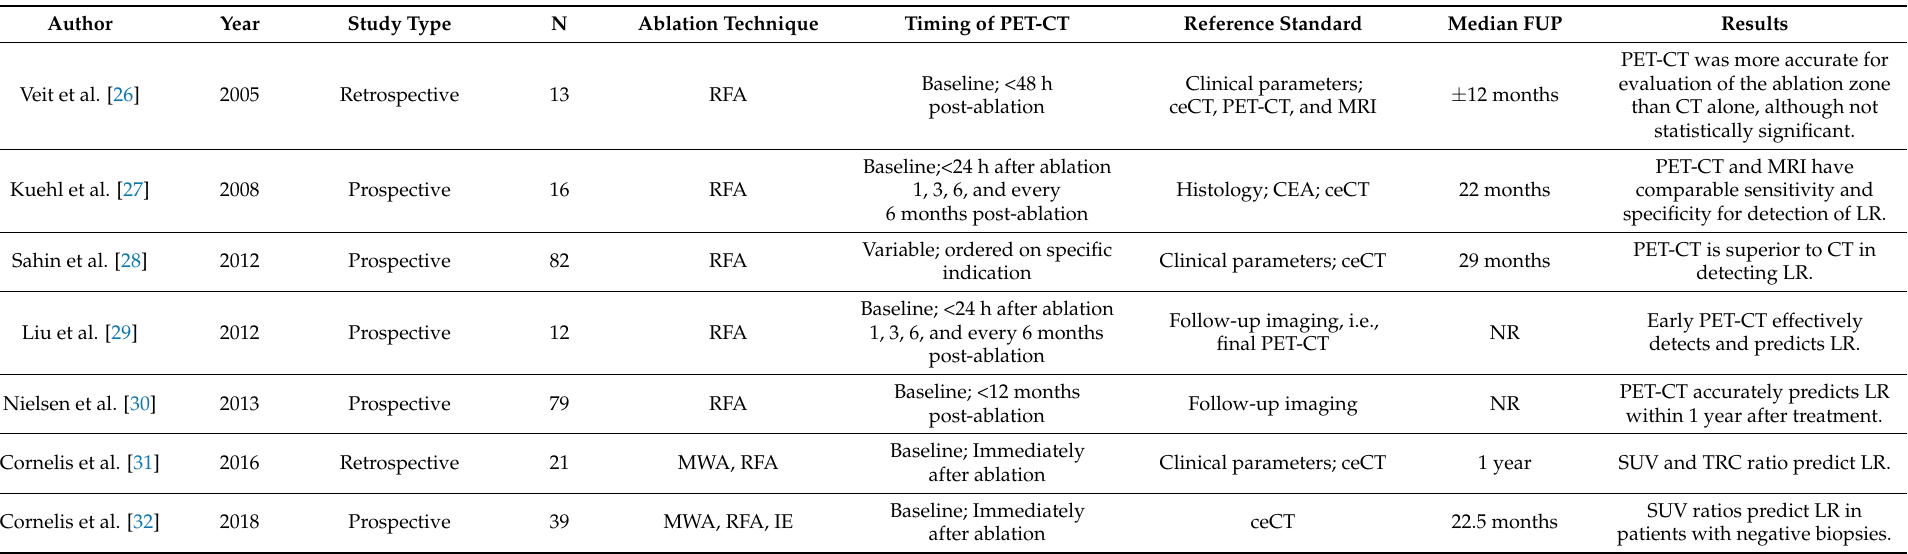
Table 2. Summary of literature studying PET-CT performance after thermal ablation of colorectal liver